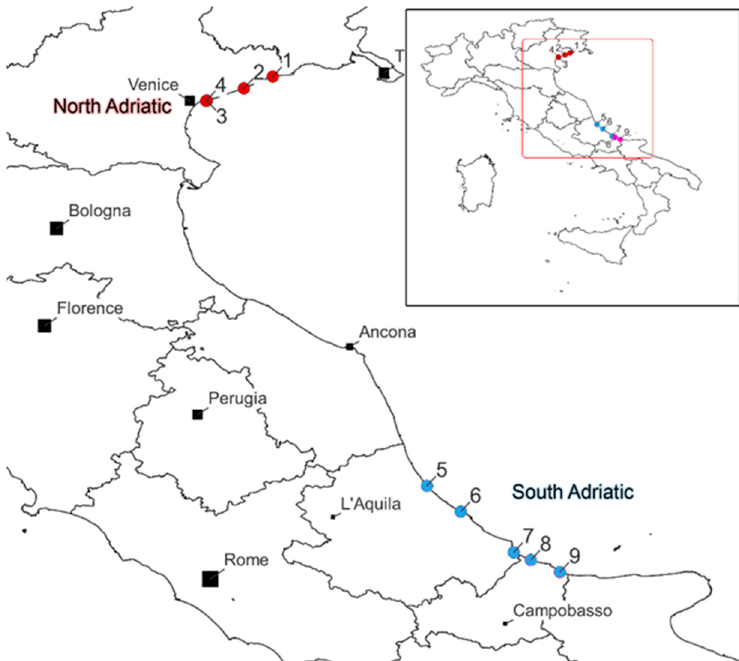
Figure 1. Study area in Italy. The sites have been colored according to their location along the Adriatic coast of Italy (red dots for North Adriatic sites and blue dots for South Adriatic sites) and labelled according to their ID. 1: Caorle, 2: Eraclea, 3: Cavallino Treporti, 4: San Michele al Tagliamento, 5: Pineto, 6: Ortona, 7: Vasto, 8: Petacciato, 9: Campomarino.